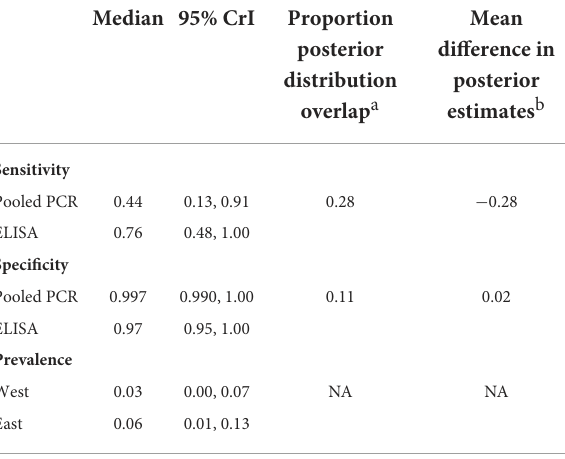
TABLE 7 Sensitivity and specificity estimates for MAP diagnosis in 635 sample pools (5 fecal samples per pool) from 3,171 beef cows in